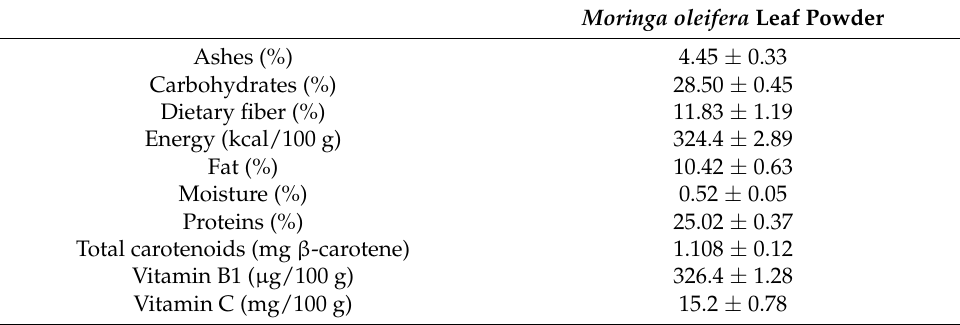
Table 1. Nutritional value of Moringa oleifera leaf